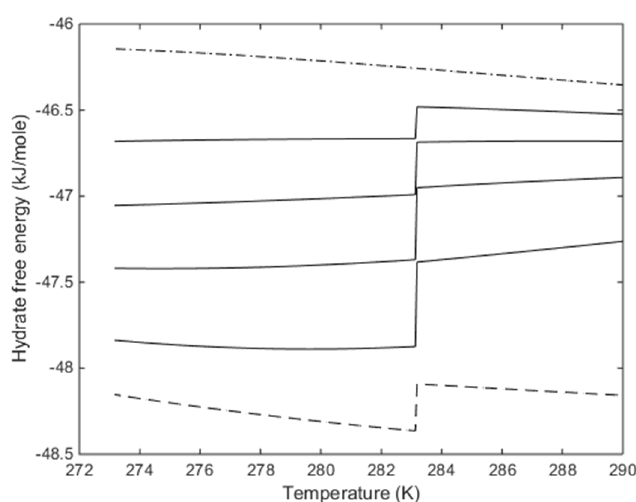
Figure 9. Free energies of hydrates from pure CH 4 and liquid water (dash-dot) along hydrate stability limits in temperature and pressure, free energies of hydrates from pure CO 2 and liquid water (dash) along stability limits in temperature pressure. Solid curves are from bottom for 80 mole per cent CO 2 , 60 mole per cent CO 2 , 40 mole per cent CO 2 and top solid curve is for 20 mole per cent CO 2 .